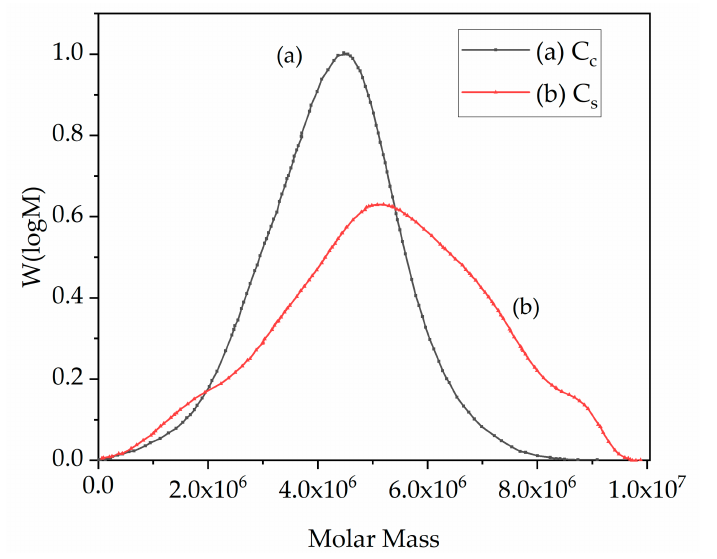
Figure 1. The weight distribution (W(logM)) versus molar mass graphs of microcrystalline cellulose powders were obtained from SEC; cellulose type C (C c , (a), black) has a narrow distribution of molecular weight while cellulose type S (C s , (b), red)) has a broader distribution of molecular